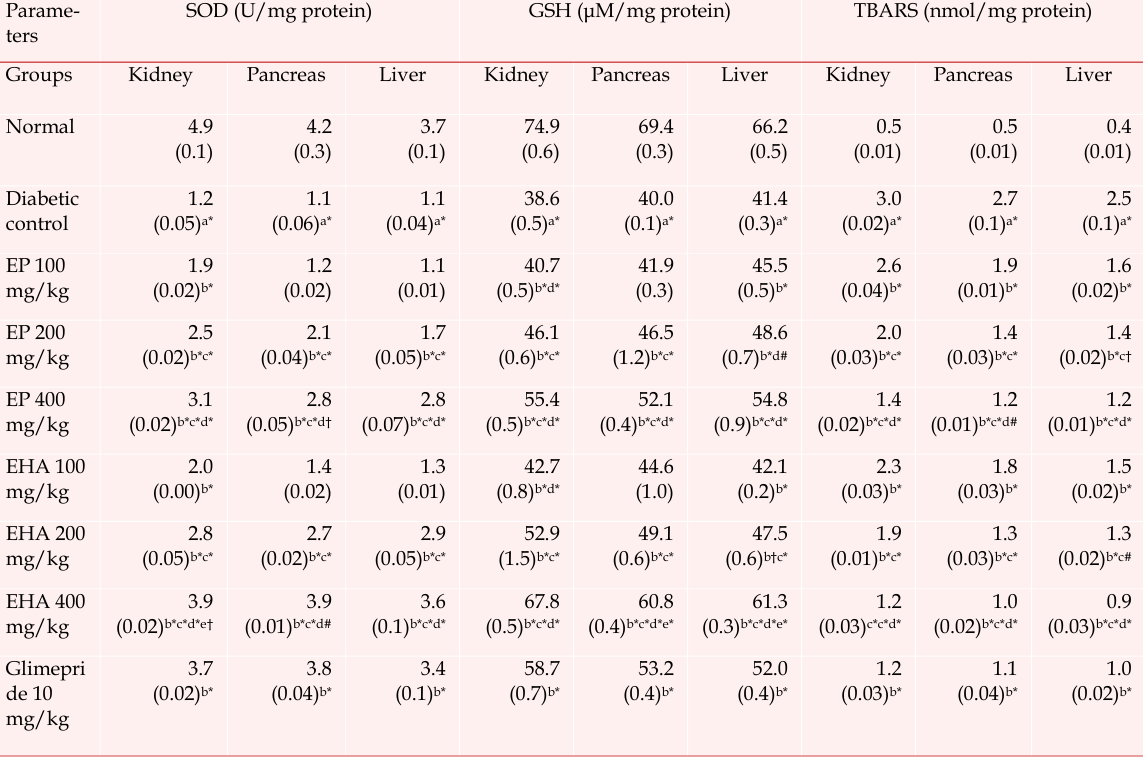
Effect of petroleum ether and hydro-alcohol extracts on the level of anti-oxidant enzymes and lipid peroxida- tion (TBARS) in diabetic-nephropathy Wistar rats Parame-